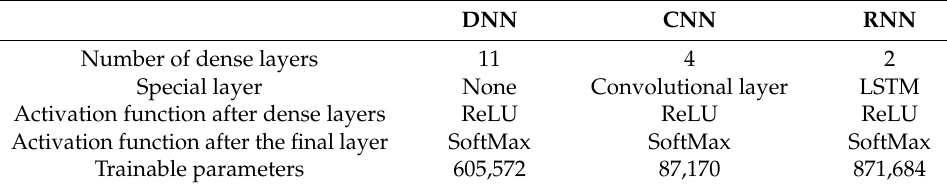
Figure 1. A simple neural network illustrating Equation (1). Inputs ( x ) multiplied by weights ( w ) are summed in the dense layer, adding bias ( b ), then the activation function ( f ) is applied to get the output. Table 1. Characteristics of the three neural network architectures used. Table 1. Characteristics of the three neural network architectures used. DNN CNN RNN DNN CNN RNN Number of dense layers Number of dense layers 11 4 2 Special layer None Convolutional layer LSTM Activation function after dense layers Activation function after dense layers ReLU ReLU ReLU Activation function after the final layer Activation function after the final layer Trainable parameters 87,170 871,684 871,684